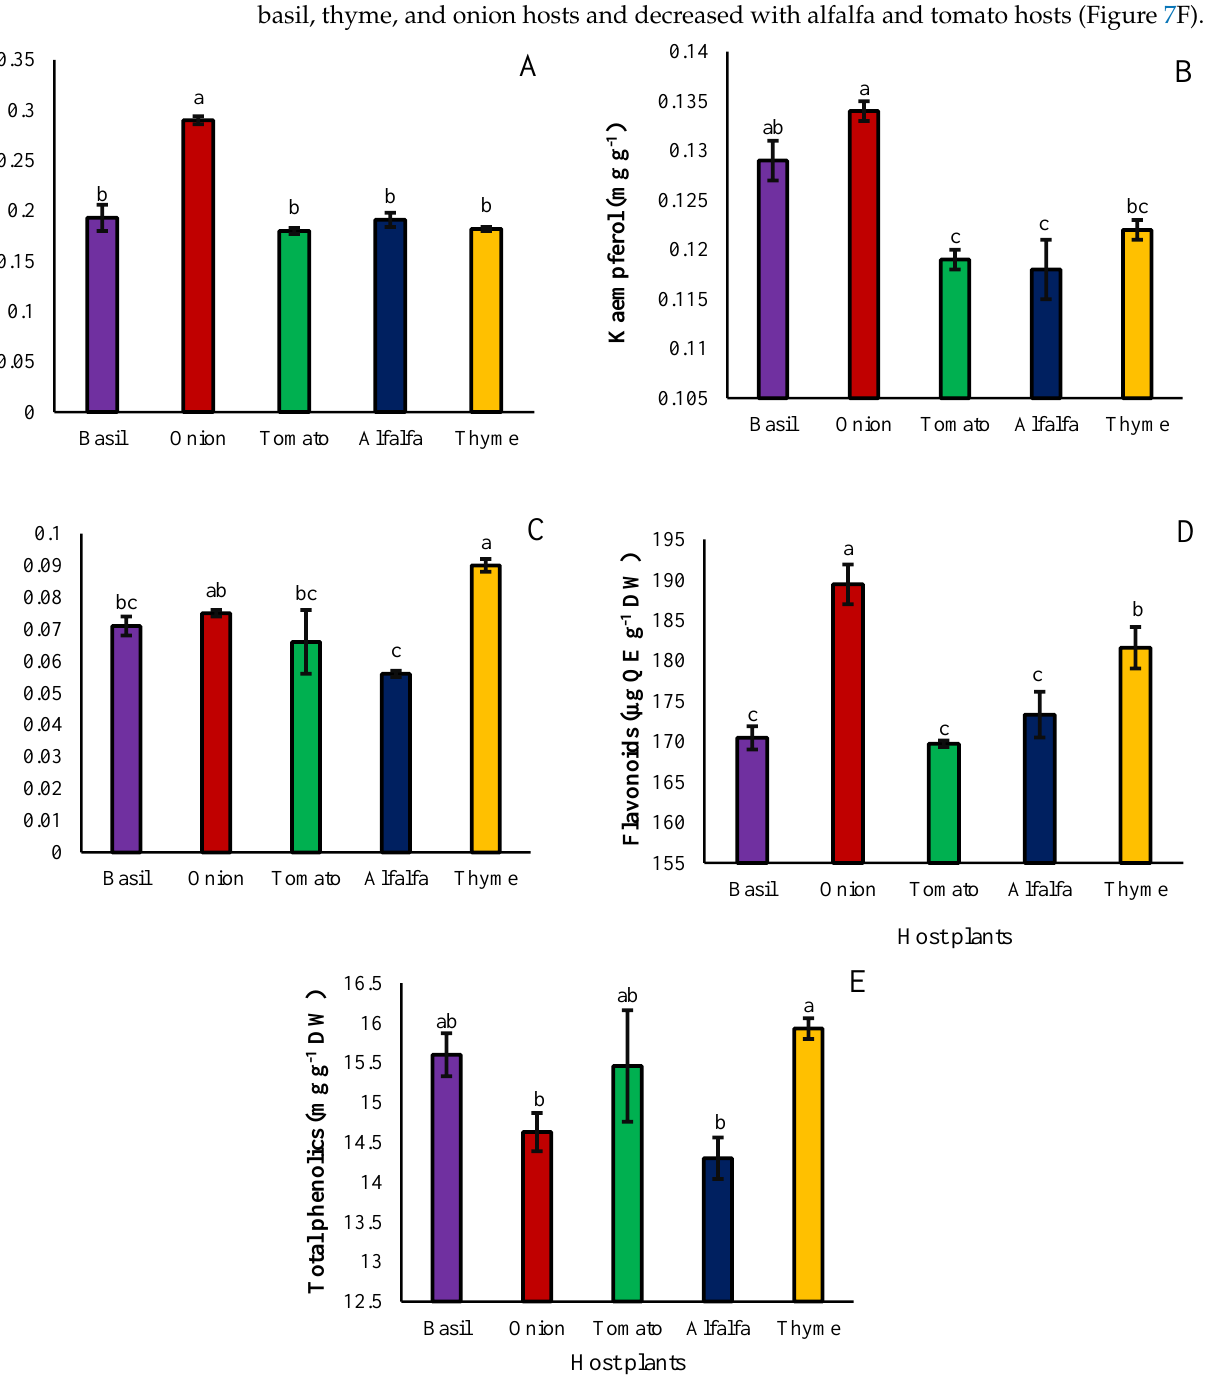
Figure 6. The effect of different hosts on quercetin ( A ), kaempferol ( B ), bergenin ( C ), total flavonoids ( D ), and total phenolics ( E ) of the Cuscuta campestris seeds set on different hosts. Bars with the same lowercase letter are not significantly different at p ≤ 0.05 for n = 3.